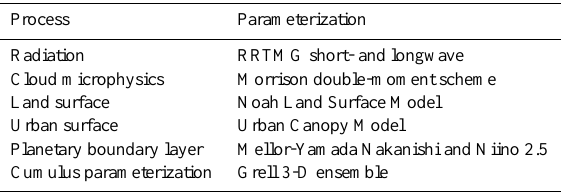
Table 1. Chosen parameterizations for selected physical processes in WRF.